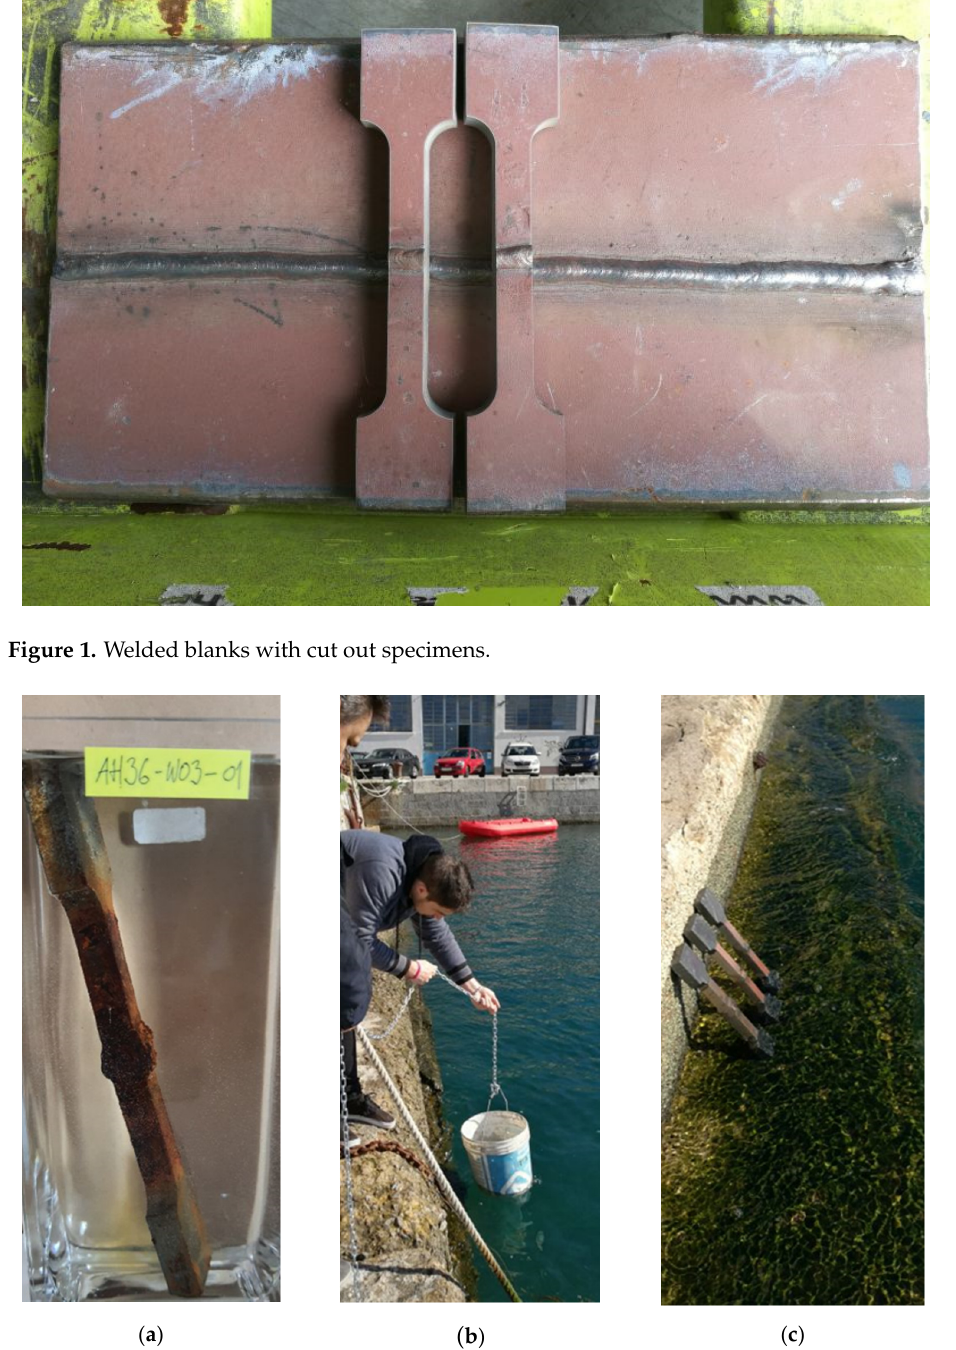
( c ) Figure 2. Exposure of specimens to corrosive environment: ( a ) water, ( b ) seawater, ( c ) sea splash. Tap water at room temperature was changed daily to ensure that specimens were in contact with fresh water. Specimens exposed in the sea were affected by changes of sea temperature, salinity, and pH value. At the location of the experiment, sea temperature